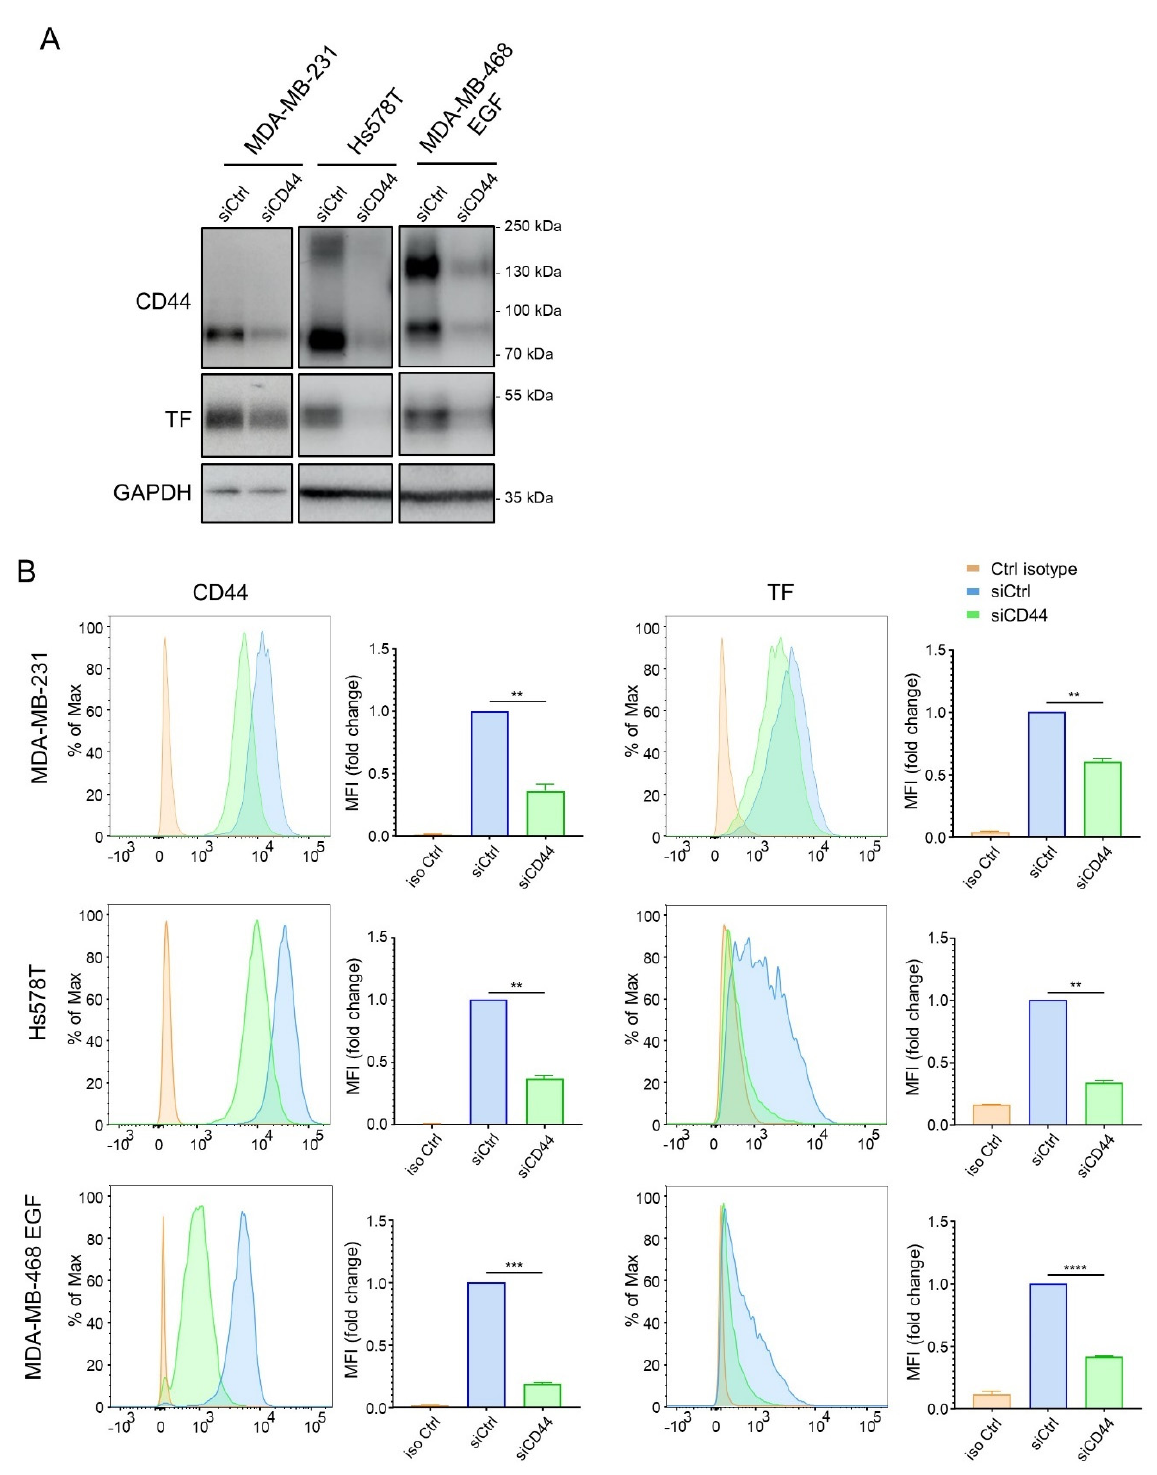
Figure 2. CD44 silencing decreases TF expression: ( A ) Western blotting analyses of CD44, TF and GAPDH in EMT + MDA-MB-231, Hs578T and EGF-treated MDA-MB-468, and transfected with a pool of 3 siRNAs directed against CD44 (siCD44) or 3 non-targeting siRNAs (siCtrl) (original western blot images are shown in Supplementary Materials) ( B ) FACS analyses and associated Mean Fluorescence Intensity (MFI) quantifications of CD44 and TF in cellular models described in ( A ). **, p < 0.01; ***, p < 0.001; ****, p < 0.0001. (Figure S3: Uncropped Western blot figures)